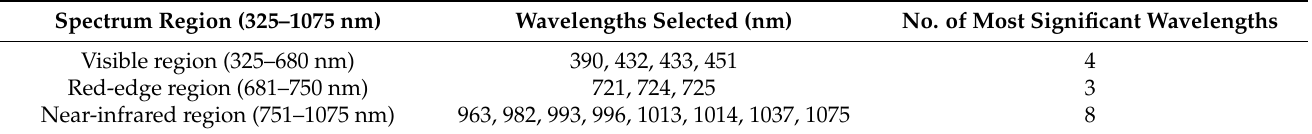
Figure 11. Histogram of reflectance spectra per wavelength showing significant frequencies with pairs of plant species. Some highest frequencies in Visible, red-edge and NIR regions are indicated with arrows. Table 6. A few of the most significant wavelength bands selected from ANOVA, based on the maximum number of significant pairs (frequencies) at each wavelength.